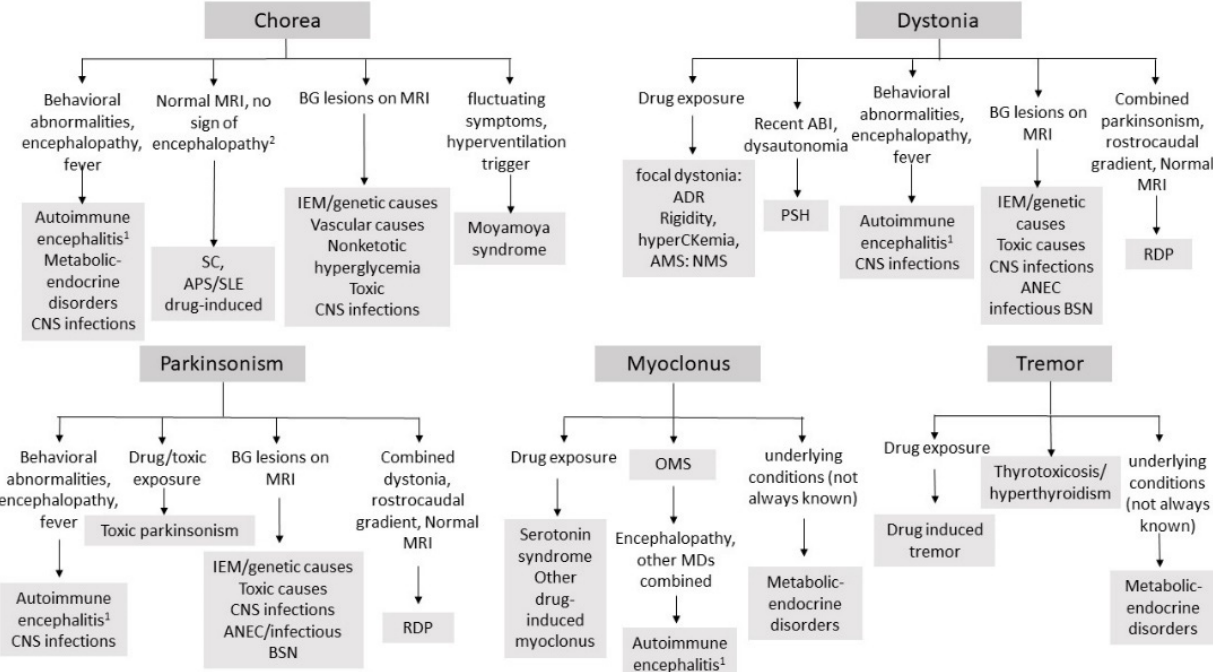
Figure 2. Essential diagnostic algorithm for acute-onset MDs, according with the predominant phenomenology. The list of suggested etiologies is not exhaustive. ADR: acute dystonic reaction; AMS: altered mental status; ANEC: acute necrotizing encephalopathy; APS: antiphospholipid syndrome; BSN: bilateral striatal necrosis; CNS: central nervous system; IEM: inborn errors of metabolism; MRI: magnetic resonance imaging, NMS; neuroleptic malignant syndrome,